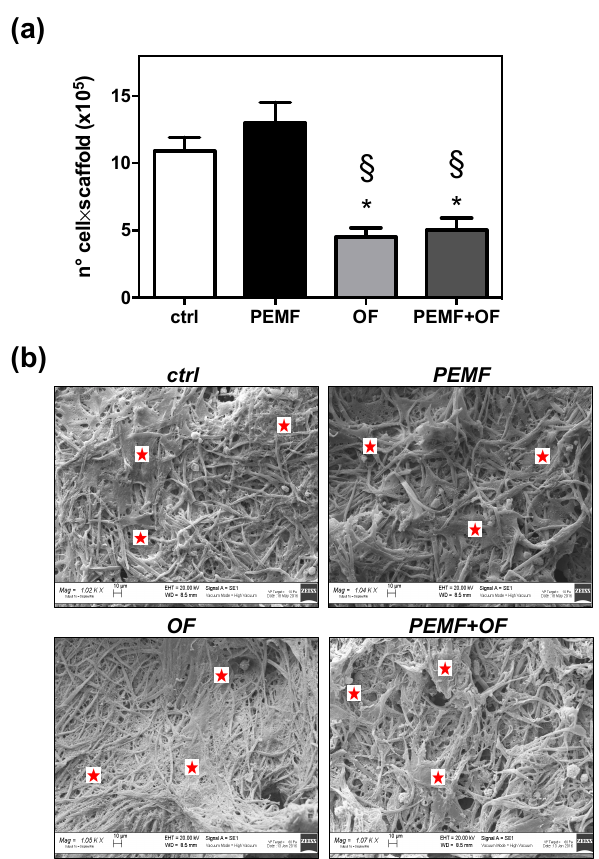
Figure 1. ( a ) Cell growth evaluation has been assessed by means of DNA quantification at day 21 of culture. Bars represent the mean values ± SD (standard deviation) of results (N = 3; n = 3, symbols indicate statistical significance vs. control (*) and vs. PEMF (§)). ( b ) Cell morphology assessed by SEM on all samples (scale bars = 10 µ m; magnification: ctrl = 1020 × ; PEMF = 1040 × ; OF = 1050 × ; PEMF + OF = 1070 × ). Red stars indicate cell distribution on the wool keratin sca ff olds in all conditions. In OF and PEMF + OF the dense layer of extracellular bone matrix (ECM) made di ffi cult to discriminate a cell from another. Representative live cells visualized by fluorescein diacetate (FDA) staining on the sca ff old’s surfaces are shown in Figure S3.